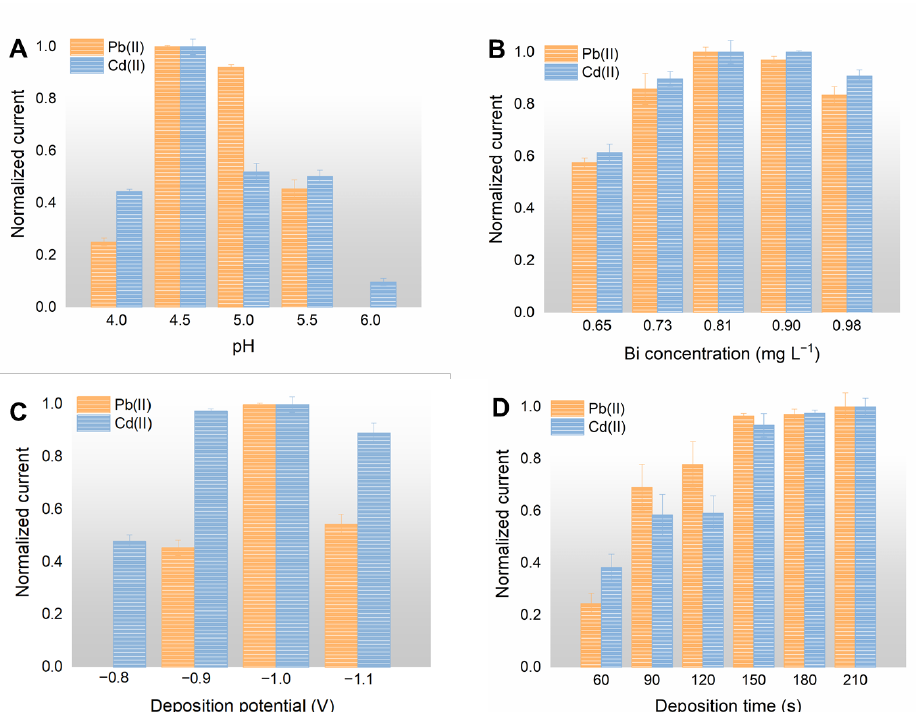
Figure 3. Influences of ( A ) the pH of the acetic acid buffer solution, ( B ) the concentration of Bi(III) ion, ( C ) deposition potential, and ( D ) deposition time on the stripping current of the